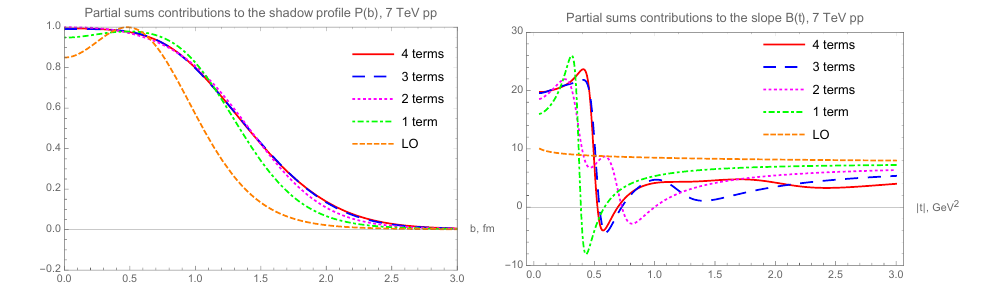
Figure 4. The shadow profile (left) and the elastic slope (right) with partial sums from leading order to fourth order Levy expansion, fitted to the TOTEM data at √ s = 7 TeV pp elastic scattering.